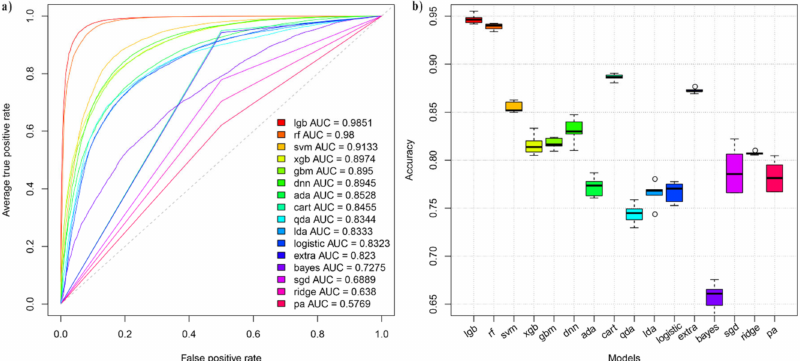
Figure 5. ( a ) Receiver operating characteristic (ROC) curves of 16 spot-checking algorithms displaying the performance on nighttime with its center at the epicenter and a radius given by the Dobrovolsky’s formula and 48 h before an earthquake (training dataset of Dataset 01). ( b ) Boxplot curves of accuracy with 16 spot-checking algorithms displaying the performance on Dataset 01. Note that the light gradient boosting machine is referred to as lgb in the figure, the other 15 algorithms are abbreviated as: